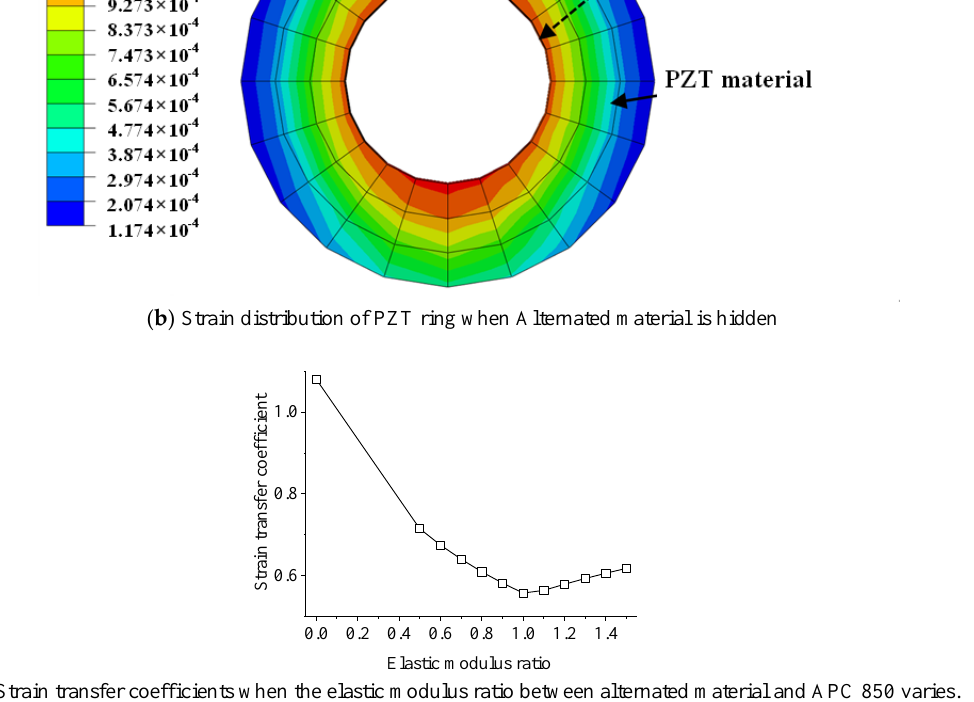
Figure 11. Strain distribution when material of PZT center is alternated.